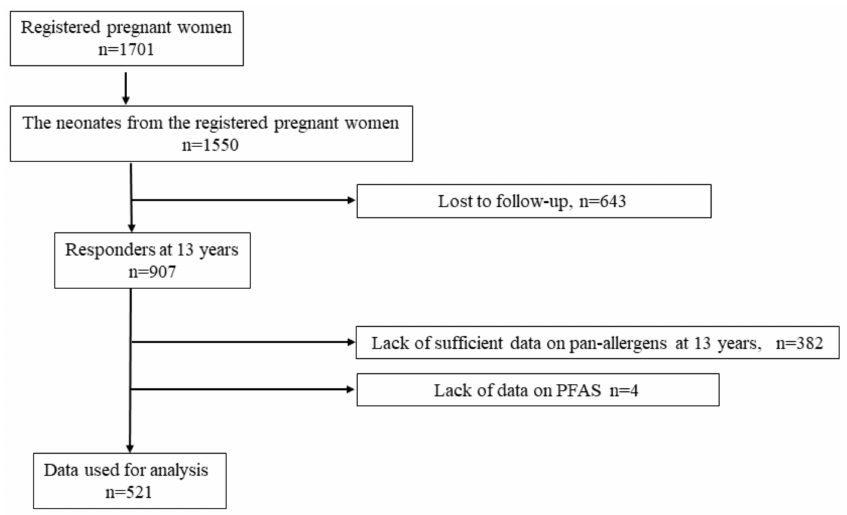
Figure 1. Flow chart of the participants included in this study. PFAS, pollen food allergy